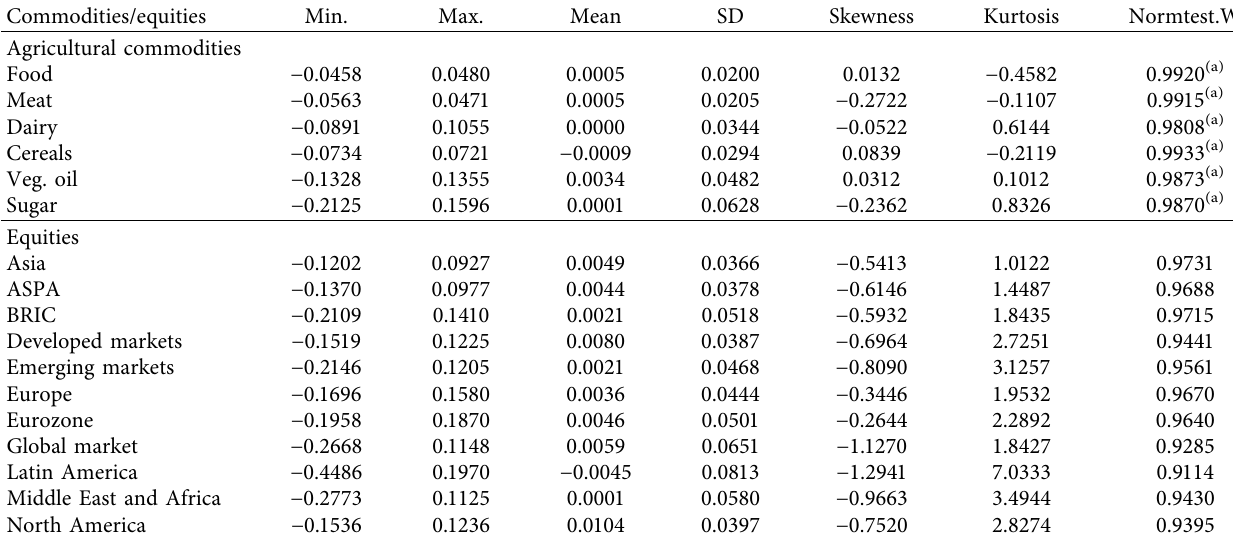
Table 1: Descriptive